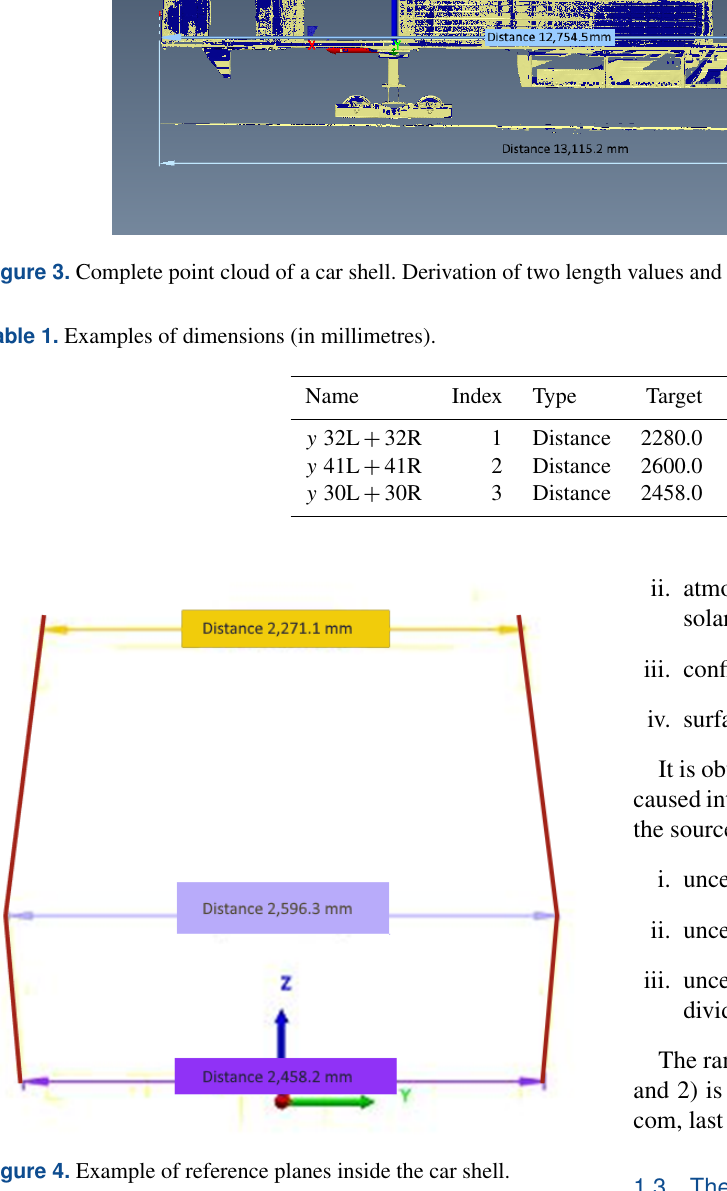
Figure 4. Example of reference planes inside the car